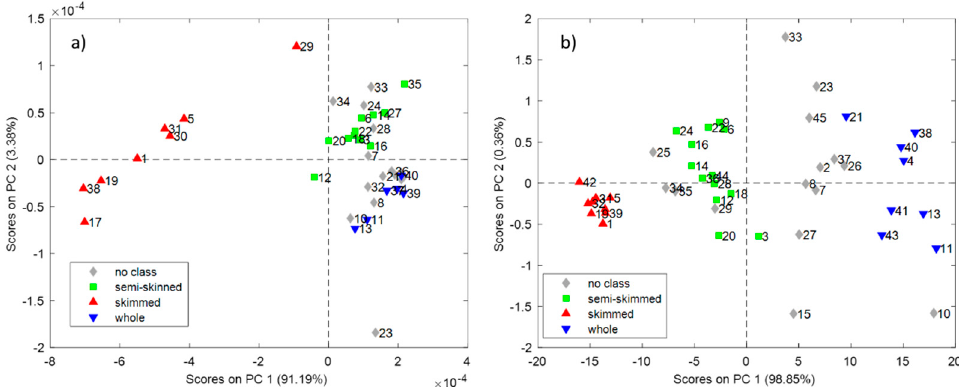
Figure 2. Score plots for the principal component analysis (PCA) models for SCiO ( a ) and NeoSpectra ( b ).